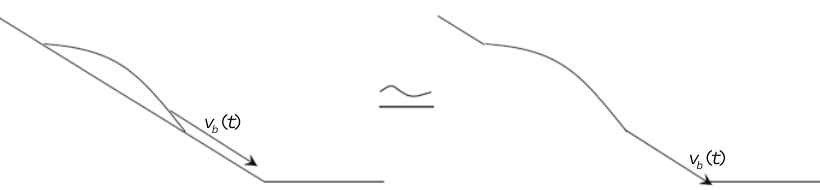
Figure 1. The treatment of the landslide moving boundary. The left is the actual movement. The right is the treatment. This could be valid only when the flow is potential and the condition on the slope is no flux.